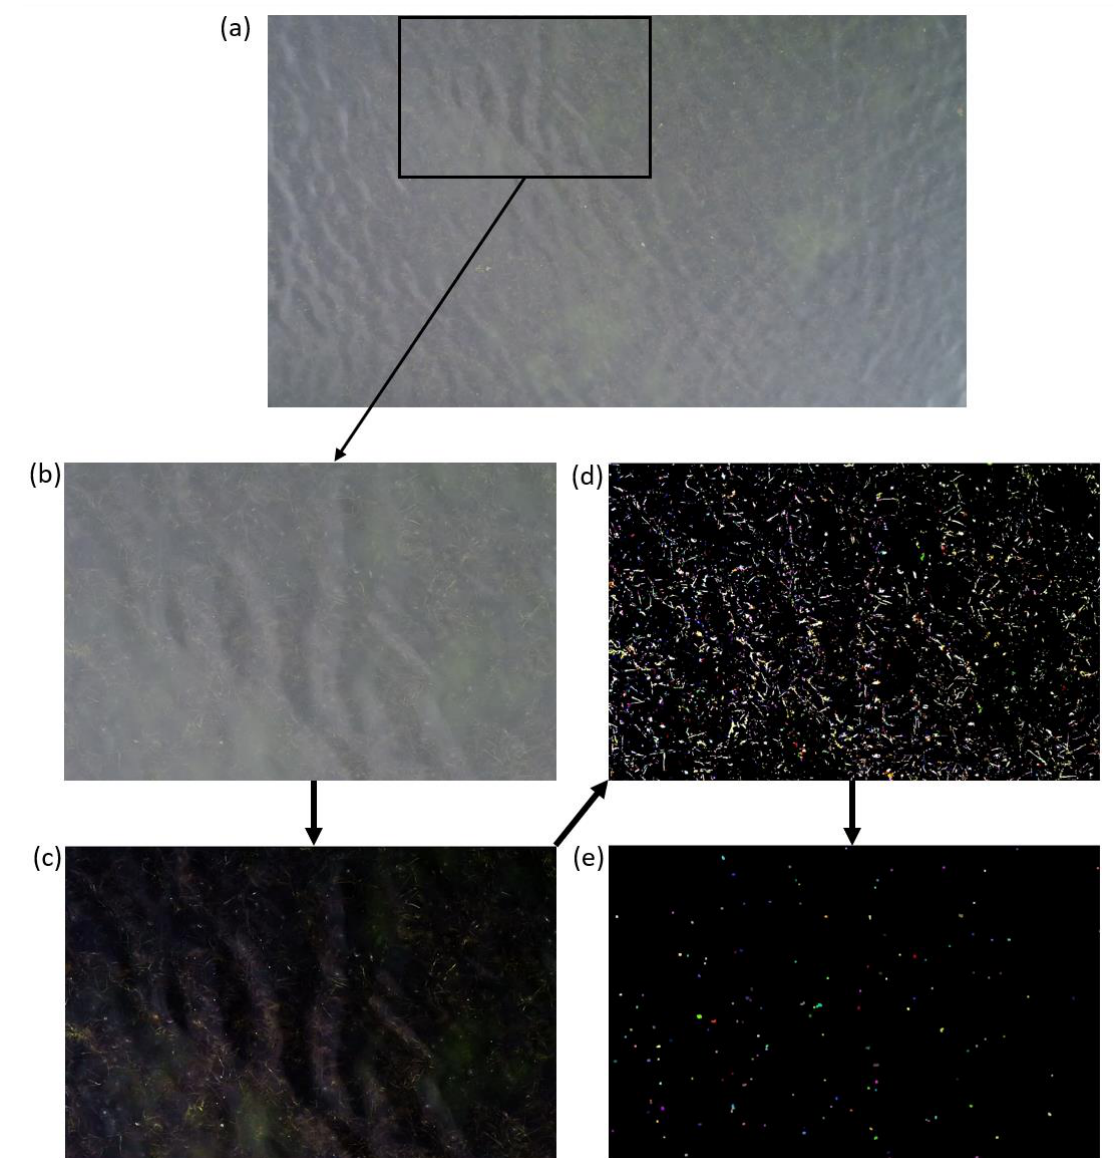
Figure 2. Image processing steps for semiautomated counting in RStudio, using data from sampling station 3. ( a ) Original drone picture with selection of area to crop; ( b ) Cropped image selected to have reduced clutter and homogeneous background (jellyfish in white); ( c ) Image obtained after automatic enhancement, with increased contrast and best gamma correction; ( d ) Elements segmented from the background using an adaptive threshold; ( e ) Image cleaned after size and shape discrimination; all jellyfish are visualized with a unique color for each individual.